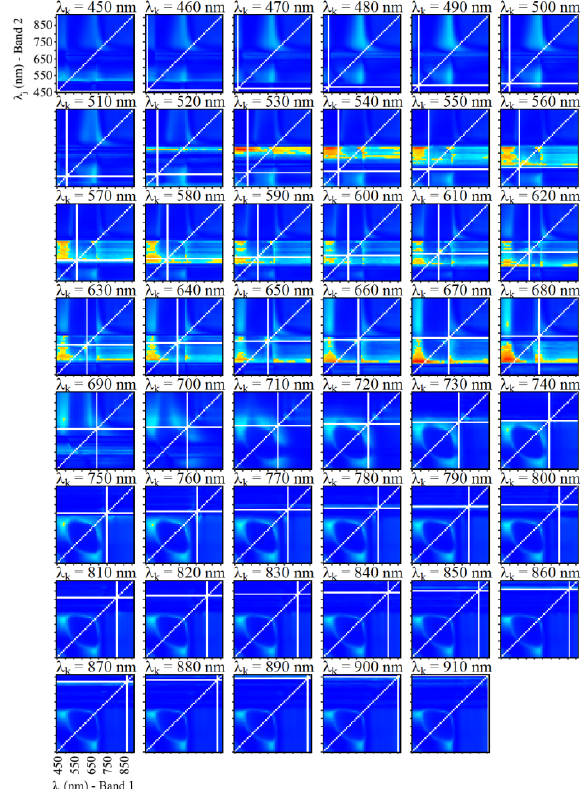
Figure 5. B-dist. for combinations of bands using RDI (same legend as Figure